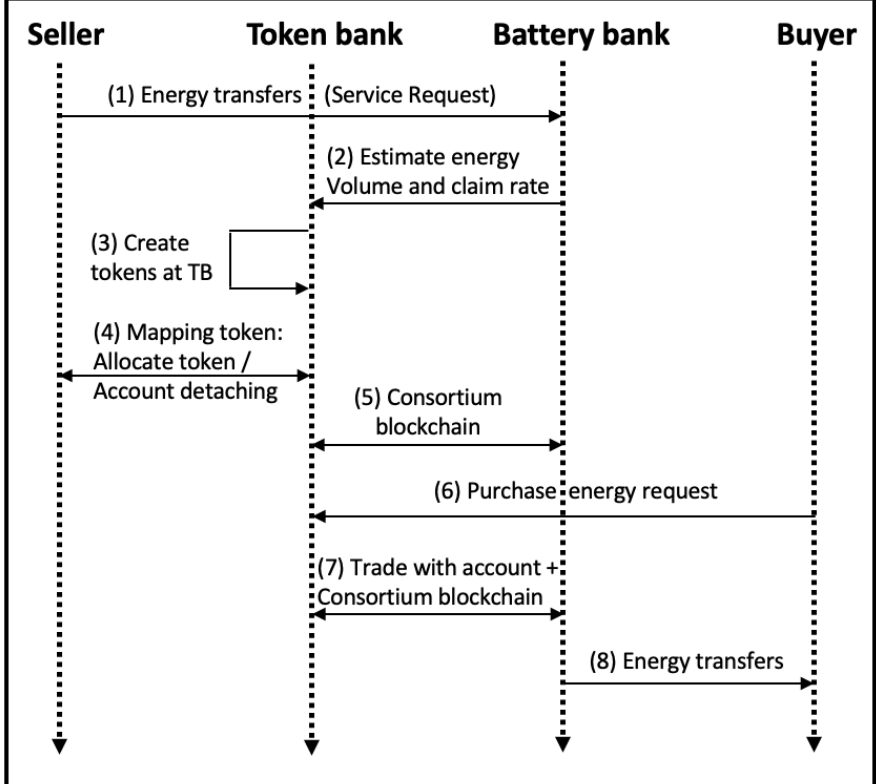
Figure 12. Main steps of trading in